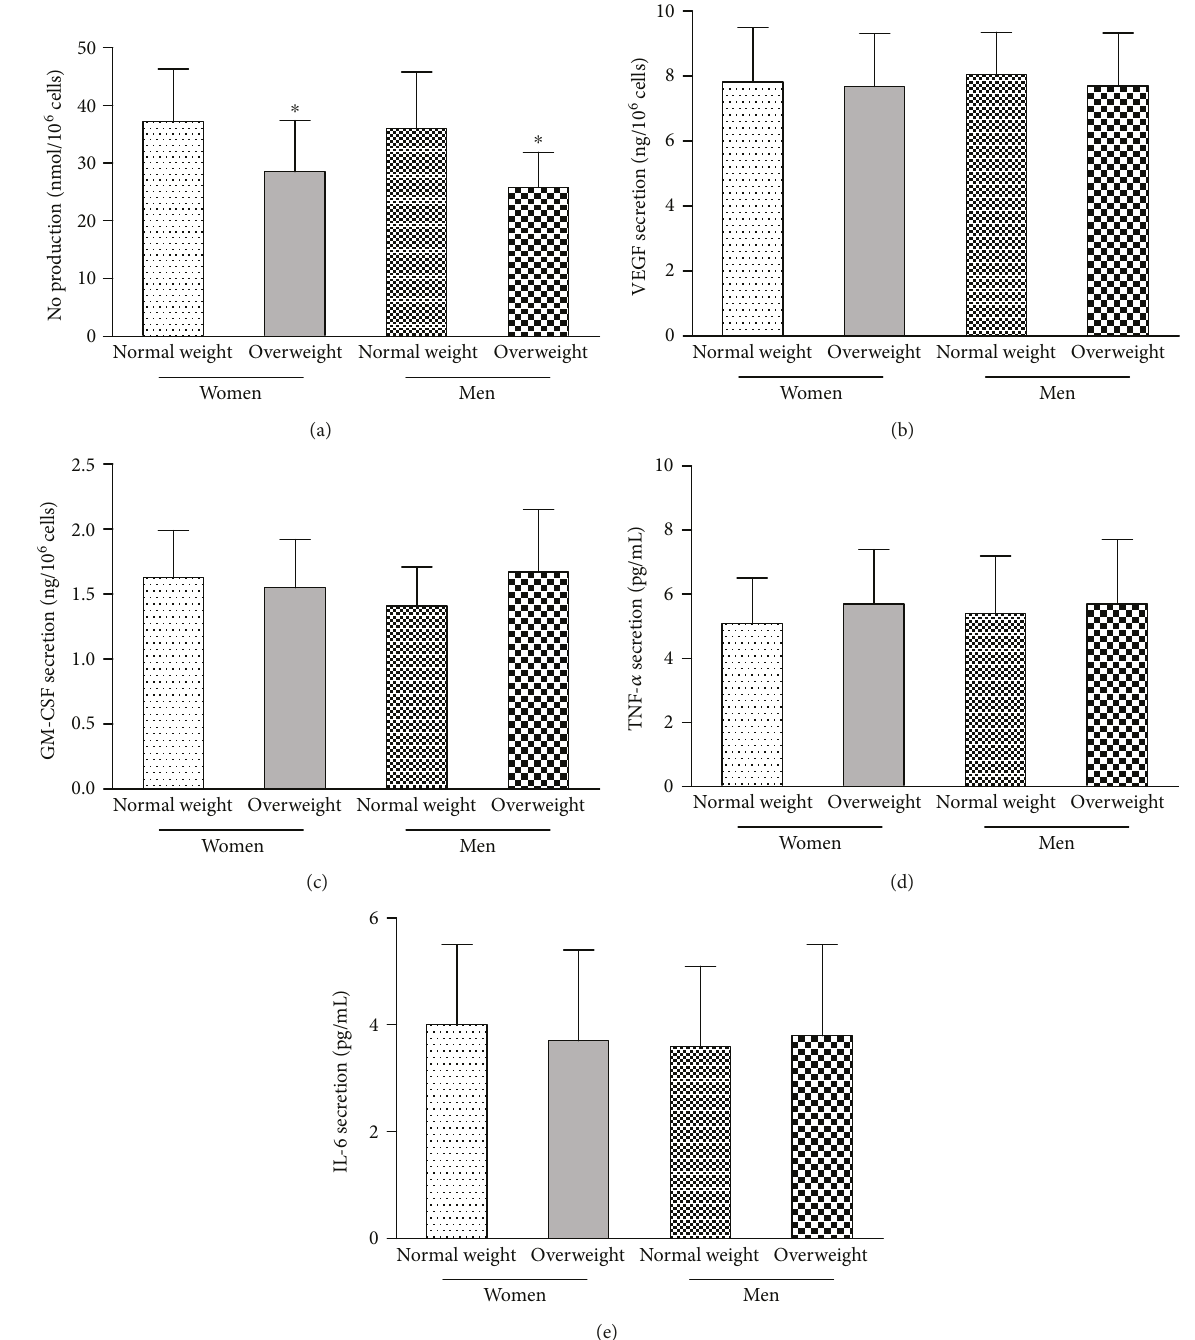
Figure 4: NO, VEGF, GM-CSF, TNF- α , and IL-6 secretion by EPCs were evaluated as follows. (a) NO secretion by EPCs in normal weight and overweight men was similar to that in normal weight and overweight postmenopausal women. The plasma NO level was lower in overweight men and postmenopausal women than in normal weight men and postmenopausal women. There was no signi fi cant di ff erence in (b) VEGF or (c) GM-CSF secretion by EPCs among the four groups. There was no signi fi cant di ff erence in (d) TNF- α or (e) IL-6 secretion by EPCs among the four groups. Data are given as the mean ± SD. ∗ p < 0 05 versus normal